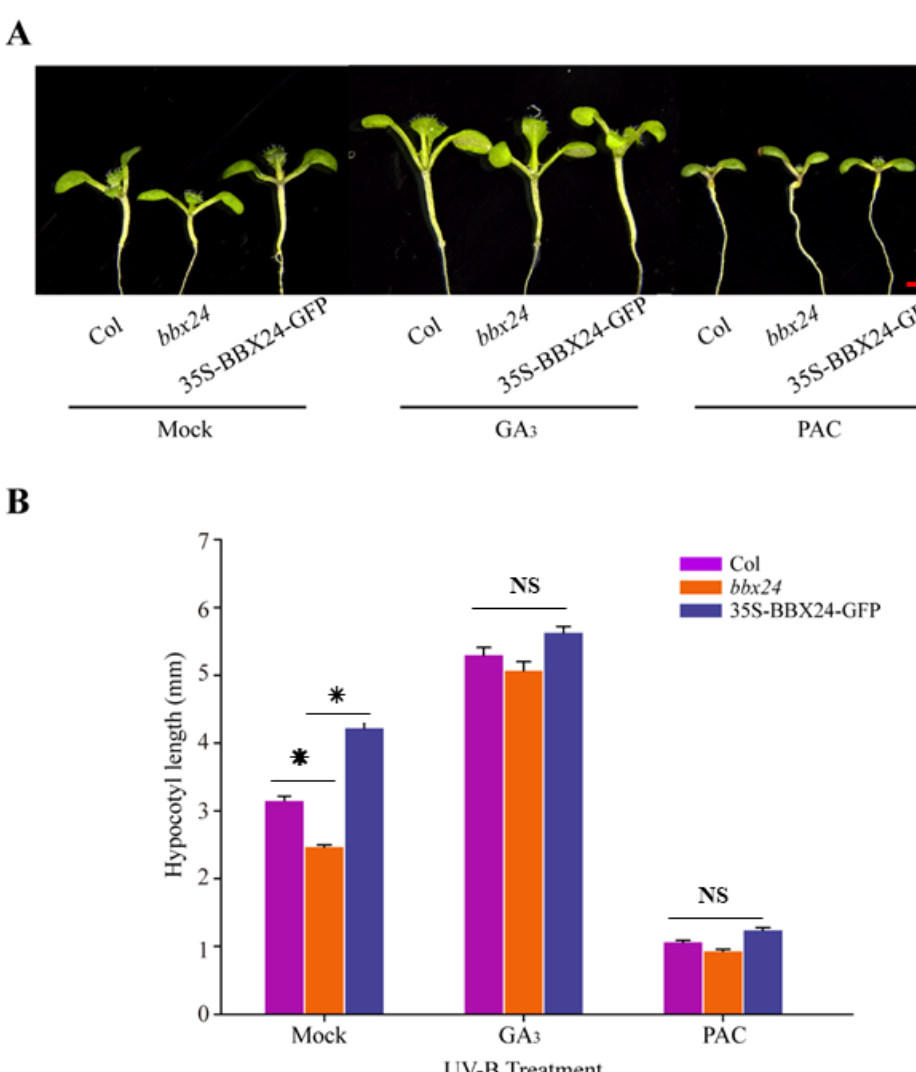
Figure 4. Gibberellins restore hypocotyl length inhibition of BBX24 seedlings under UV-B radiation. ( A , B ) Hypocotyl phenotypic analysis. Seedlings of Col-o , bbx24 mutant, and 35S-BBX24-GFP were grown for 5 days and then transferred to UV-B radiation after growth for 3 days under white light. Images of the representative seedlings (mock, 1/2MS; GA 3 : 5 µ M PAC: 0.5 µ M, GA synthesis inhibitor) are shown in ( A ). The hypocotyl lengths of the indicated genotypes were measured and are shown in ( B ). Error bars indicate SE ( n ≥ 15). Bar = 1 mm. The asterisks indicate statistically significant differences between the hypocotyl lengths of the indicated seedlings grown in the presence of UV-B radiation, “NS” means “No Significance” represents no significant difference between these columns, as determined by Tukey’s least significant difference test ( p < 0.05). When exposed to UV-B radiation, inhibition of the rga-24 mutant hypocotyl was the weakest, and bbx24 mutant hypocotyl inhibition was the strongest. The rga-24 bbx24 double mutant’s hypocotyl length was between that of the rga-24 and bbx24 mutants (Figure 5). These results showed that RGA and BBX24 antagonistically regulate UV-B